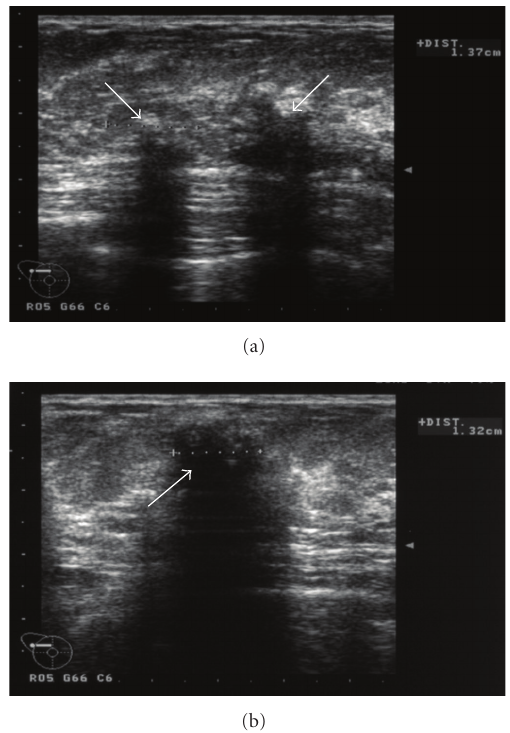
Figure 1: Ultrasound shows multiple, ill-defined hypoechoic areas with acoustic shadowing, indicating multiple coarse calcifications within the right breast (arrows).